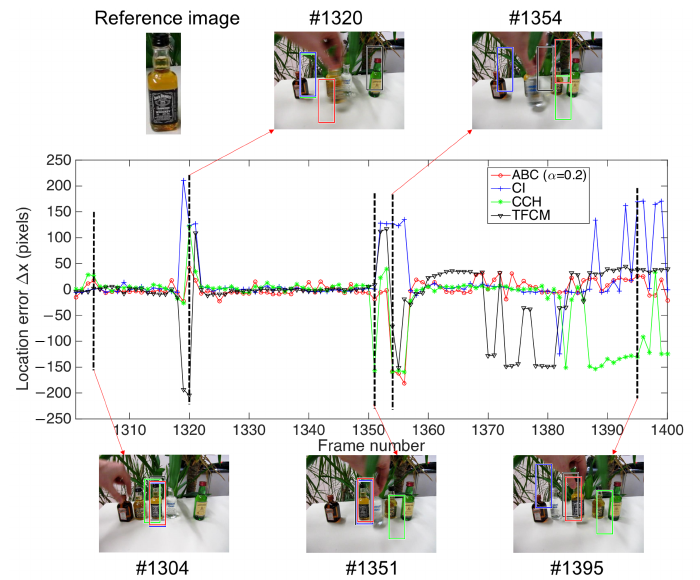
Figure 14. Tracking by ABC ( α = 0.2), CI, CCH and